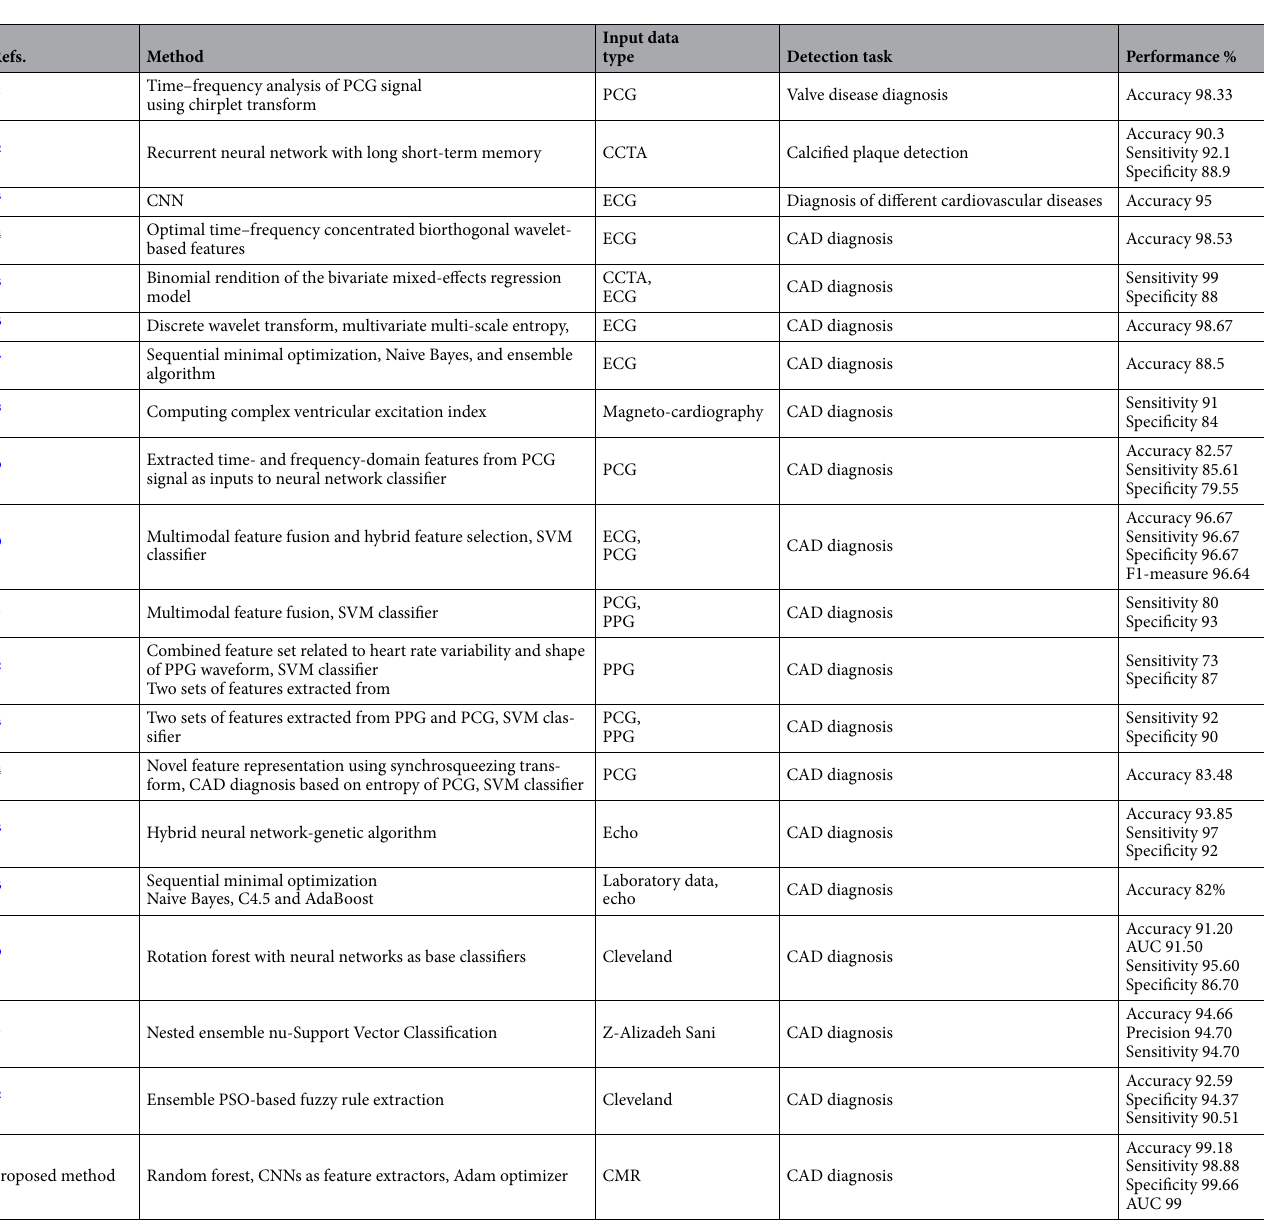
Table 4. Overview of related works based on various input types. ECG Electrocardiograph, Echo Echocardiography, PCG Phonocardiograph, PPG Photoplethysmography, SVM Support vector